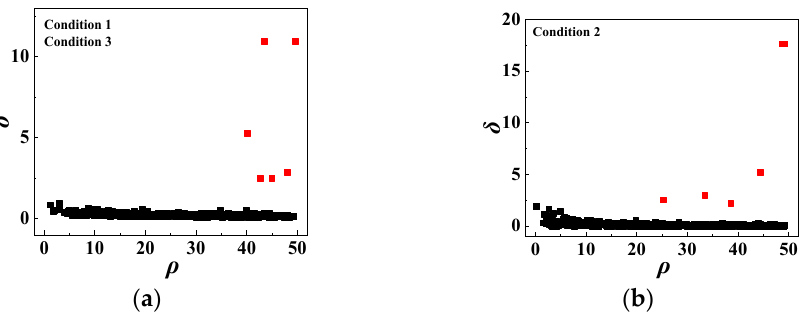
Figure 11. The result of subclass center after unsupervised classification. ( a ) Condition 1 and 3. ( b ) Condition 2. Table 3. The average value of OA AA and Kappa coefficient.